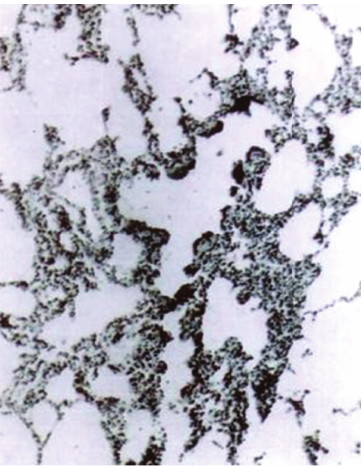
Figure 12: Section of lung of T. canis -infected dog depicting interstitial pneumonia (H. E. original magnification × 70X).